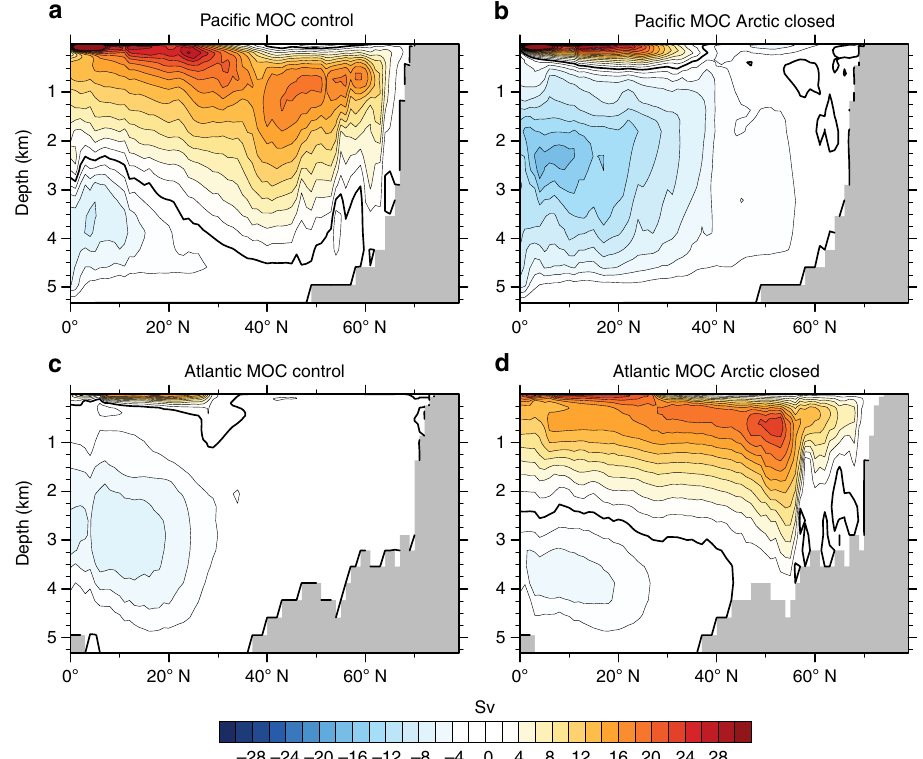
Fig. 3 Meridional overturning circulation (MOC) in the North Paci fi c versus North Atlantic basins. a Paci fi c MOC in the control run, b Paci fi c MOC with the Arctic – Atlantic gateway closed, c Atlantic MOC in the control run and d Atlantic MOC with the Arctic – Atlantic gateway closed. In the control simulation, there is strong overturning in the North Paci fi c, while the North Atlantic remains strati fi ed. Once the Arctic – Atlantic gateway is closed, North Atlantic overturning is triggered, while North Paci fi c overturning shuts down. Southern Ocean overturning is present in both